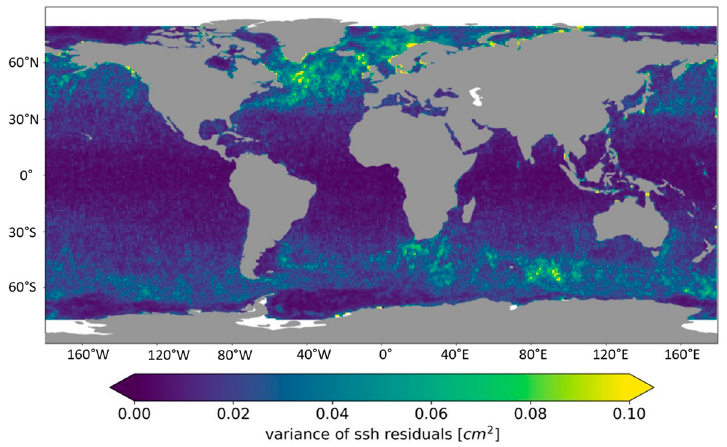
Figure 14. Variance of the SSH residuals (Glorys scenario).